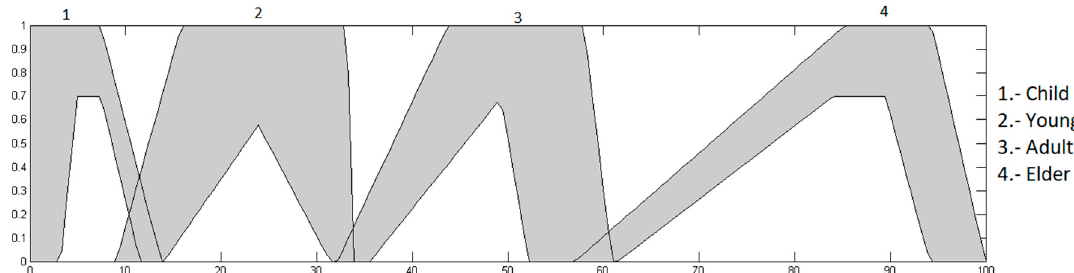
Figure 25. Optimized input age with trapezoidal MFs.